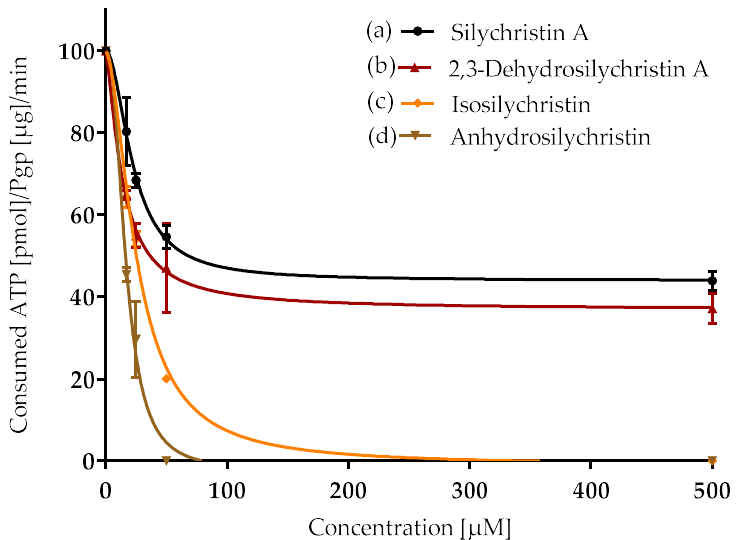
Figure 5. Inhibition of P-glycoprotein (transmembrane efflux pump belonging to the ATP binding cassette family) by silychristin derivatives: ( a ) silychristin A; ( b ) 2,3-dehydrosilychristin A; ( c ) isosilychristin; ( d ) anhydrosilychristin. Data are presented as the average of three measurements with corresponding standard error of the mean. The Y max /Y min values were as follows: ( a ) 100/44 ± 2; ( b ) 100/37 ± 2; ( c ) 100/0; ( d ) 100/0.